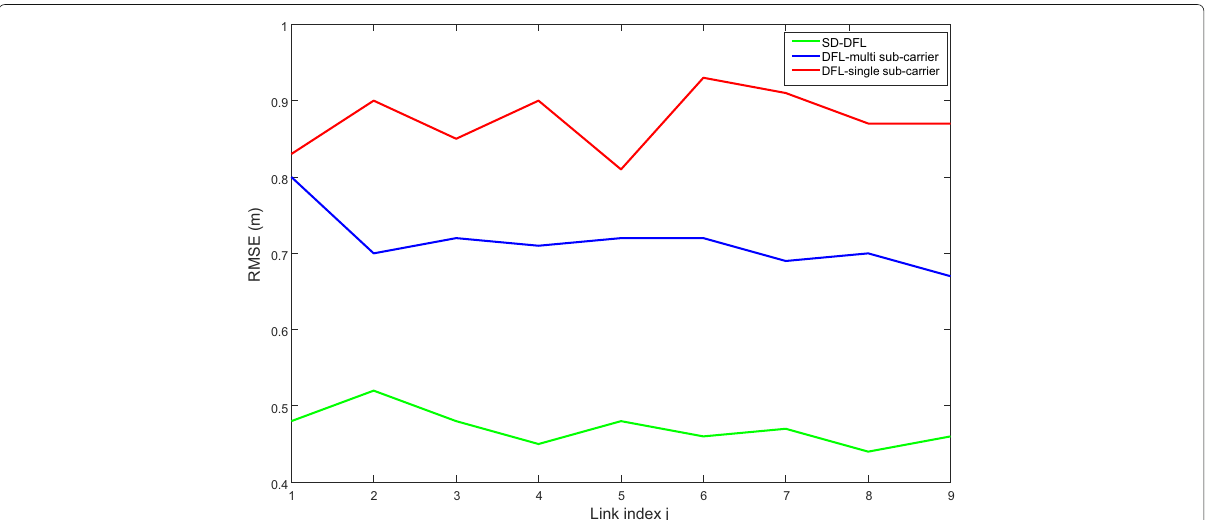
Fig. 11 DFL performance comparison. RMSE (m) of location estimation vs. link index in the double target scenario using the MIMO single sub-carrier ( f 15 ) method (red line), the MIMO OFDM sub-carriers scheme (blue line), and the proposed SD-DFL MIMO-OFDM approach (green